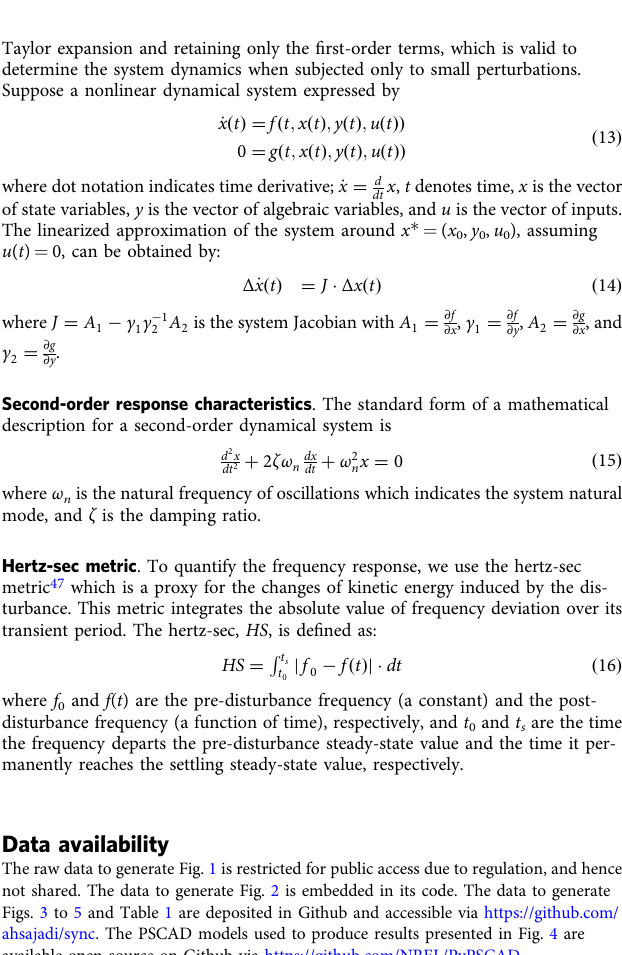
available open-source on Github via